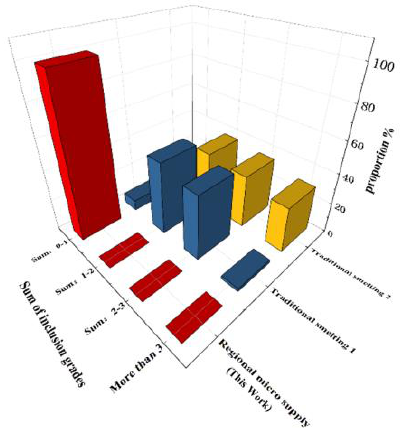
Figure 2. The proportion of sum of inclusion grades in P91 steel prepared by different methods [24].